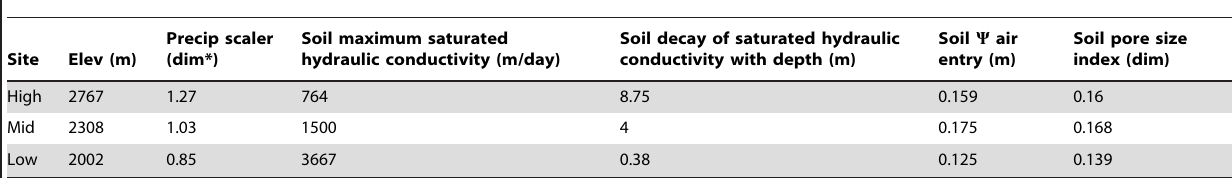
*dim = dimensionless, Precip scalar is the multiplier on input daily precipitation data to adjust for cross site differences in rainfall inputs.